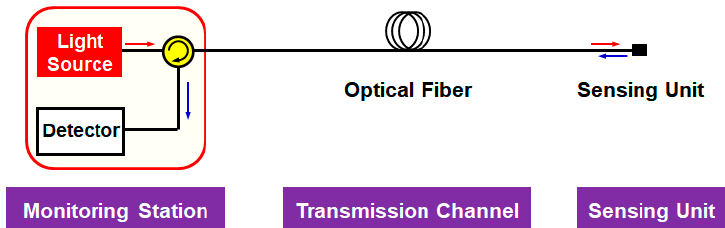
Figure 1. Basic architecture of a passive optical fiber sensor network (point-to-point).